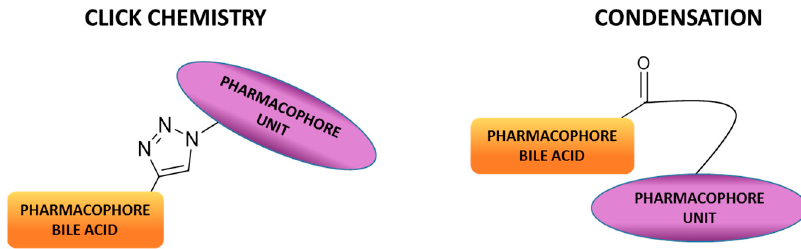
Figure 2. Sketch of BA-hybrids via click chemistry or condensation reaction.